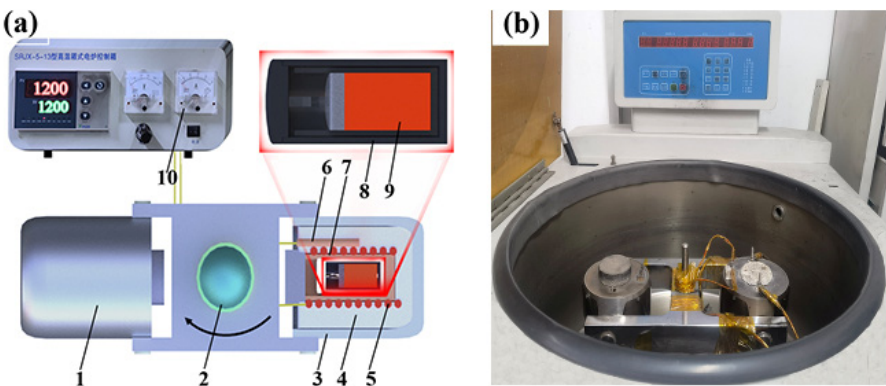
Figure 1. Schematic ( a ) and image ( b ) of the centrifugal apparatus: (1) counterweight; (2) centrifugal axis; (3) heating furnace; (4) refractory materials; (5) resistance coil; (6) thermocouple; (7) furnace chamber; (8) graphite and quartz crucible; (9) metal melts and covering slag; (10) temperature controller.